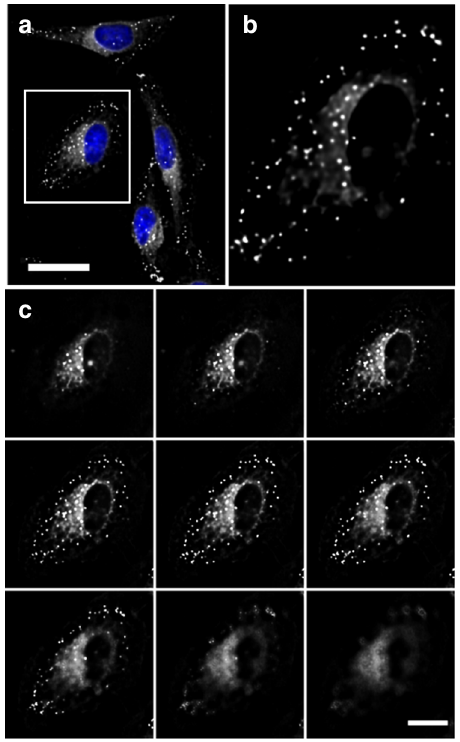
Fig. 8 Fixed HeLa-Kyoto cell imaging following 2 h incubation with NP 1- P 188. a Representative multiple cell view. b Expansion of single cell area highlighted in a . c Z -stack analysis of cell shown in b . Scale bars = 20 μ m. ( fl uorescence shown in white for clarity). See Supplementary Fig. 14 for an additional independent imaging